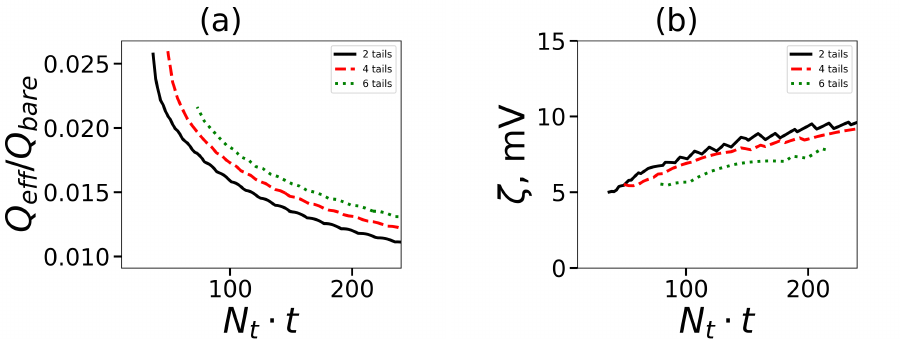
Figure 9. ( a ) The relative effective charge and ( b ) the zeta-potential ζ (in Volt) at different amounts of hydrophobic segments in tails. All cases correspond to the same generation number G =